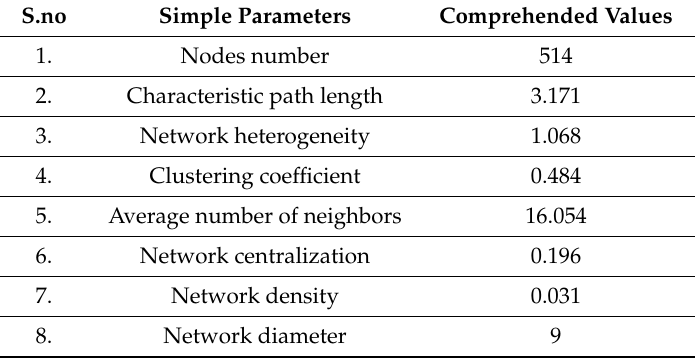
Figure 2. The Venn diagram of gene intersection between the three gene sets of T1D, T2D, and MODY. The plot depicts the similarities and differences between the obesity-associated genes among T1D, T2D, and MODY. The blue, red, green circles represent T1D, T2D, and MODY, respectively. Table 1. Network statistics of string interactions from the Cytoscape plugin (NetworkAnalyzer) for the identified obesity genes associated with type-1 diabetes (T1D), type-2 diabetes (T2D), and maturity-onset diabetes of the young